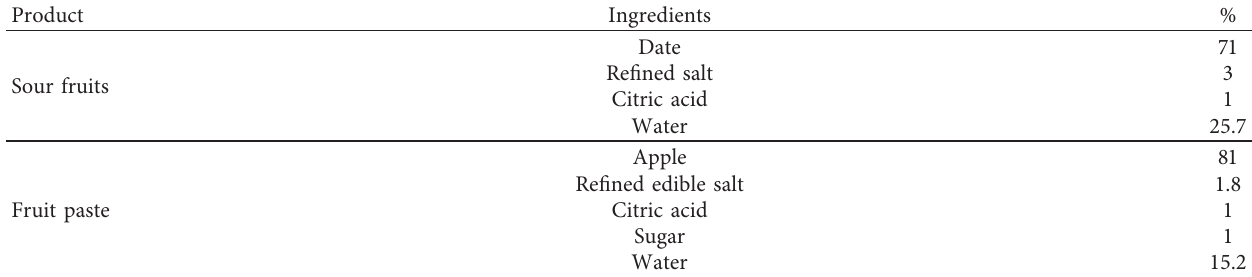
Table 1: Ingredients used in the main formulation of processed fruits.